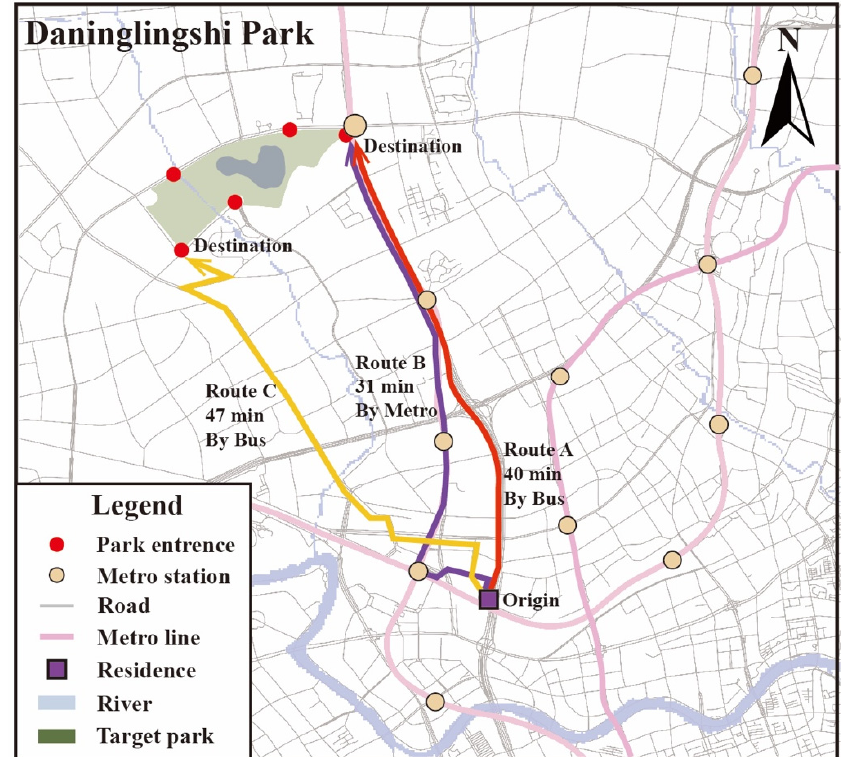
Figure 3. Travel time estimation by Route Planning APIs for an identified trip to Daninglingshi Park (B13).